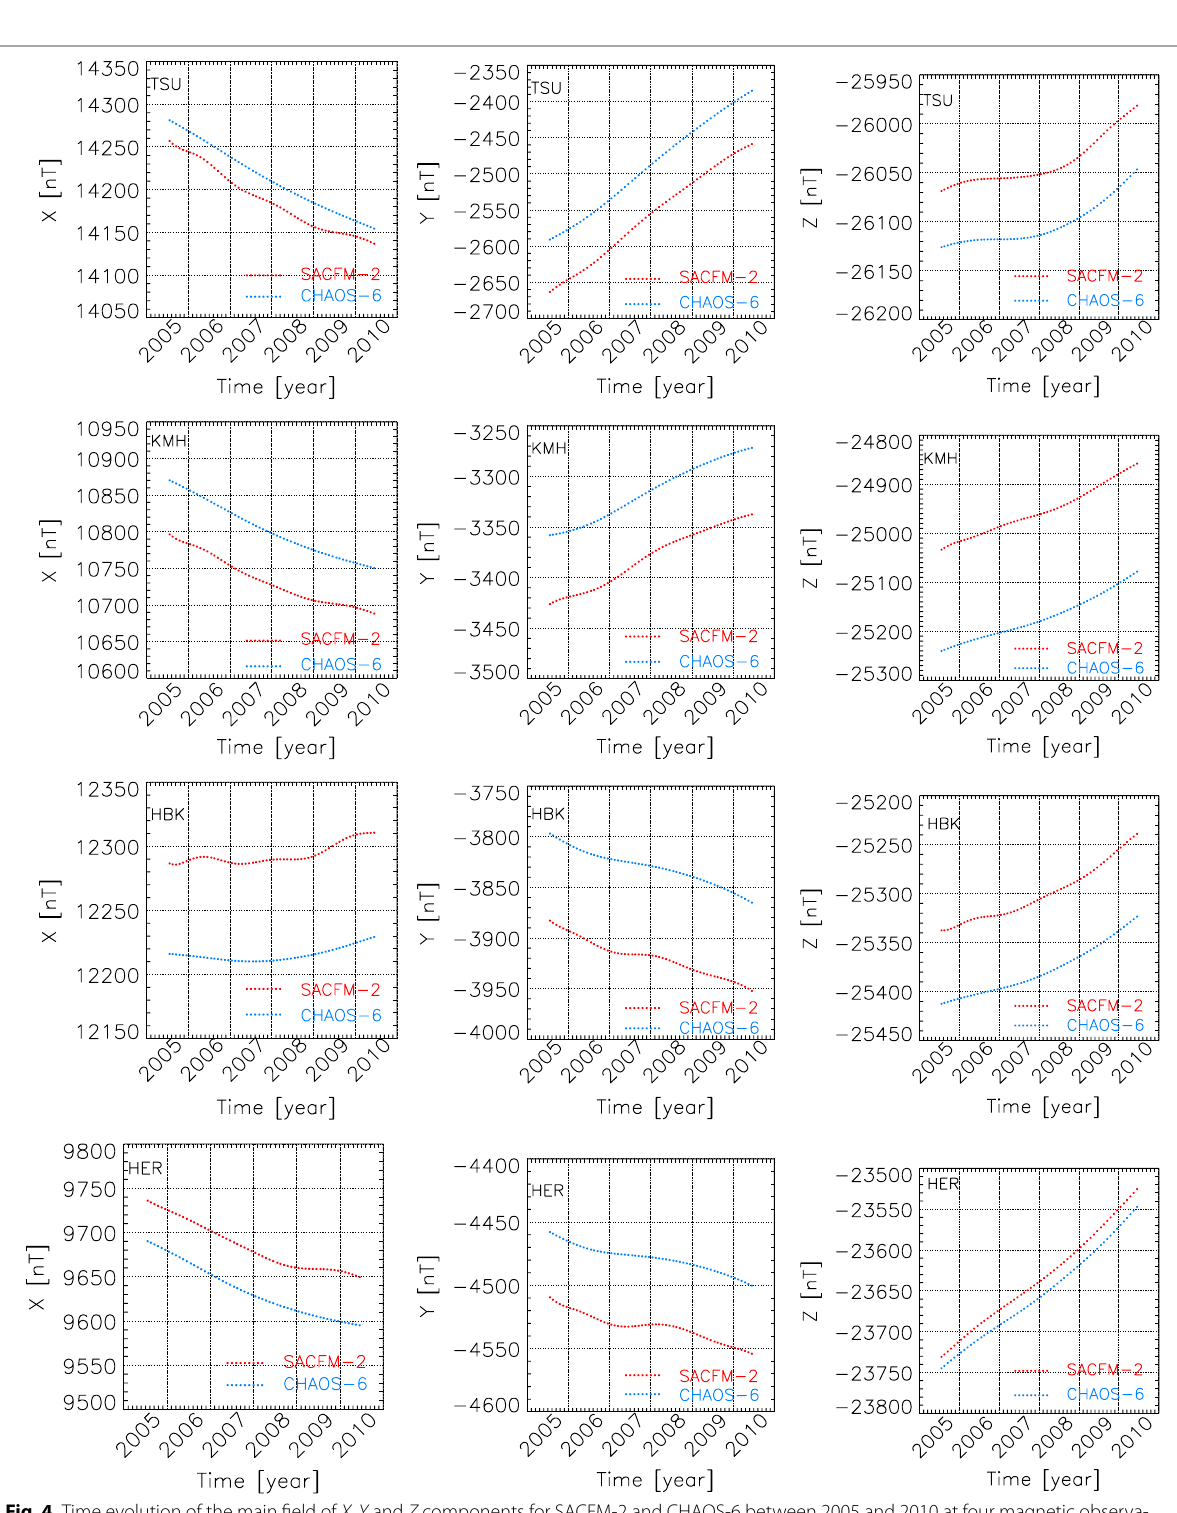
Fig. 4 Time evolution of the main field of X , Y and Z components for SACFM-2 and CHAOS-6 between 2005 and 2010 at four magnetic observatories (TSU, KMH, HBK and HER). Synthesised main field data are calculated at the centre of each month between 2005.5 and 2010.5. The three columns from left to right are for X , Y and Z components, respectively. The four rows from top to bottom are for TSU, KMH, HBK and HER observatories,